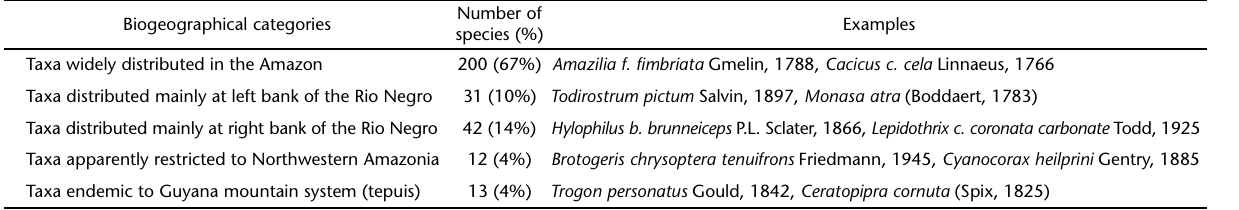
Table III. Taxa (species or subspecies) recorded in Aracá region distributed in major biogeographic categories. For more details in categories definition see Methods section. Biogeographical